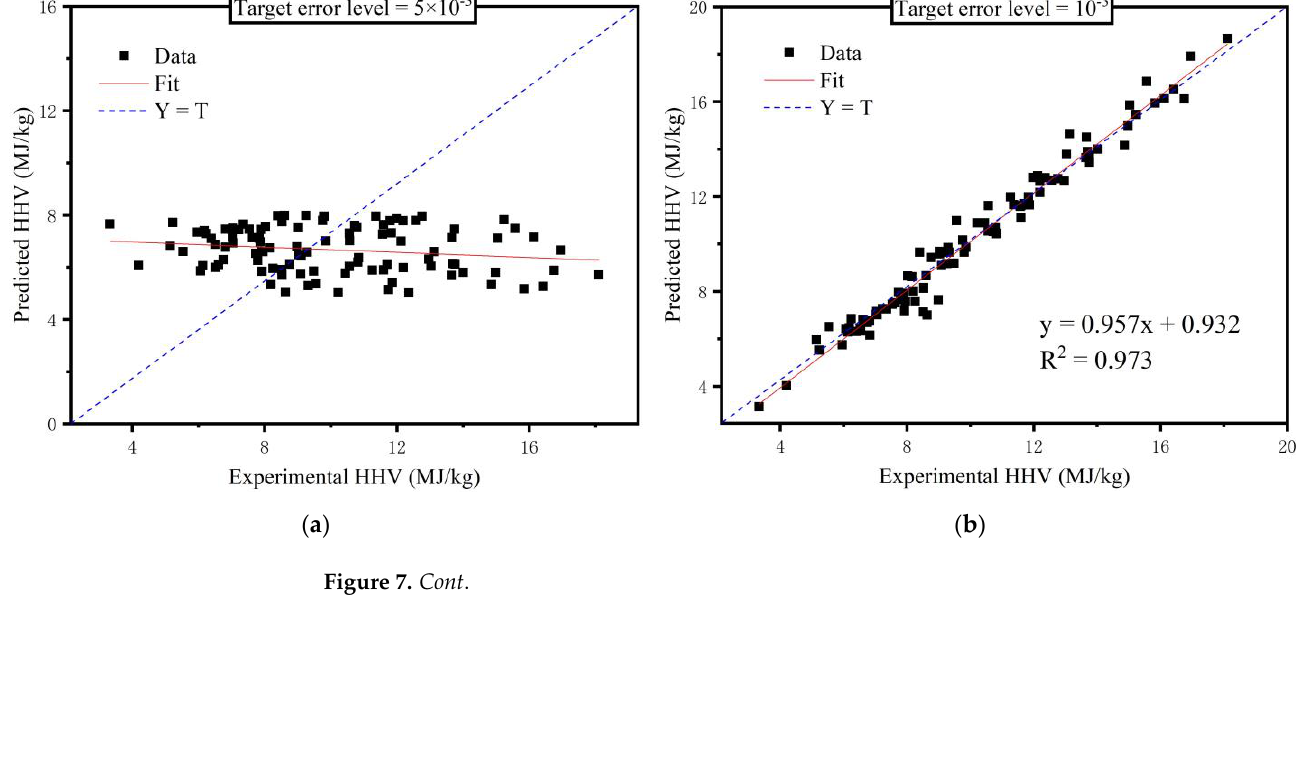
Figure 6. Performance of the network with different hidden layers: ( a ) indicates the situation where the hidden layers are 12; ( b ) indicates the situation where the hidden layers are 13.